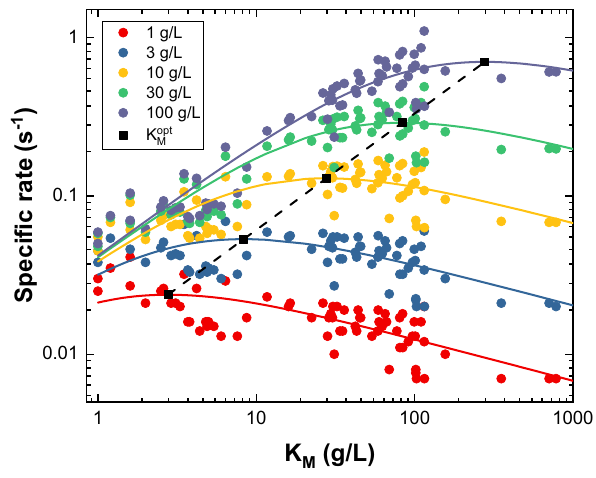
Fig. 6 Volcano plots for fi ve different substrate loads. The speci fi c rate at fi ve different substrate loads is plotted as a function of K M for the investigated enzymes (excluding outliers identi fi ed in Fig. 2). Points represent experimental data and solid lines are the predicted volcano curves calculated using Eq. 6 and a = 0.74 (there are no free parameters in the determination of these solid curves). Black squares represent K M,opt values calculated using Eq. 7, and these points identify the maxima of the volcano plots at a given load of